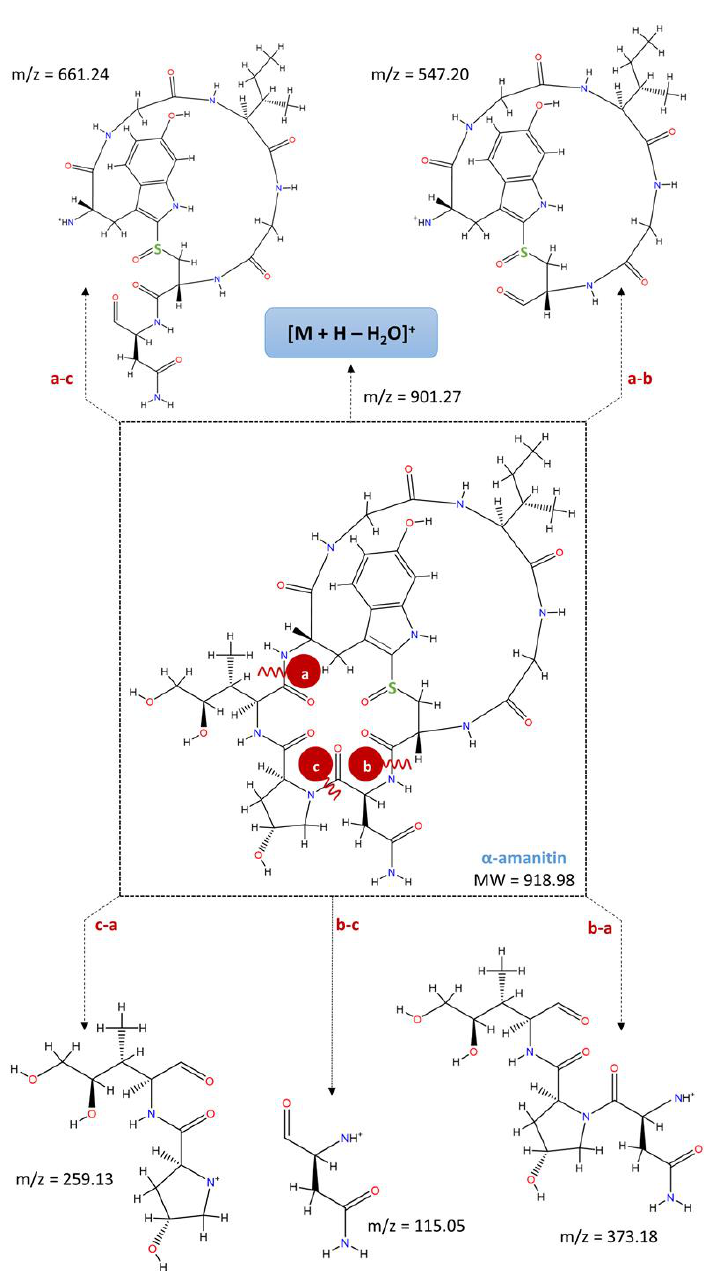
Figure 6. Schematic representation of the fragmentation sites in the chemical structure of α -amanitin and the respective characteristic fragments produced with the corresponding m/z values.